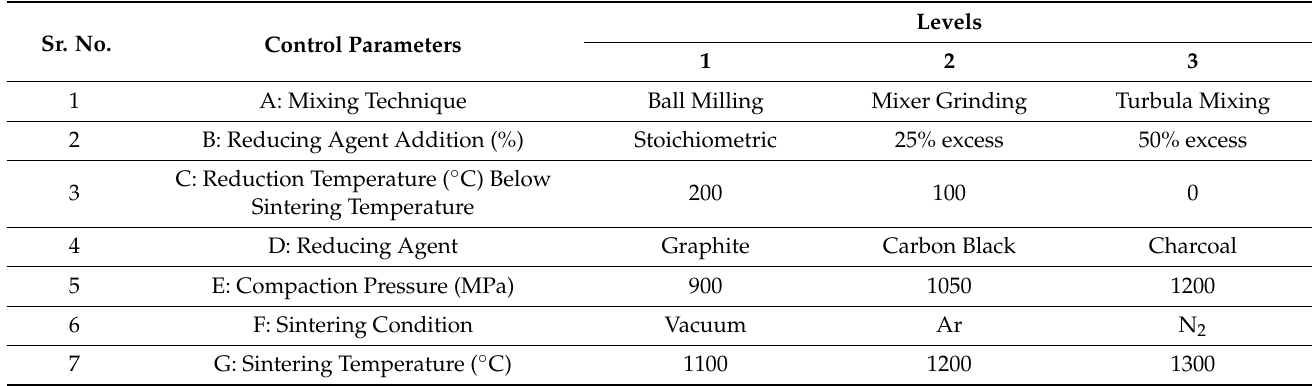
Table 5. Control parameters with their respective levels used in the